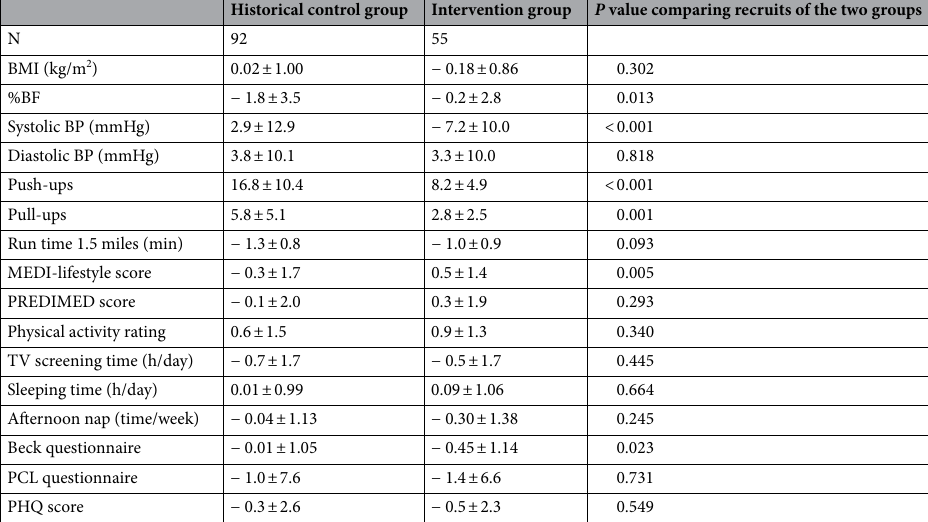
Table 2. Changes in recruits’ selected body composition and physical fitness measurements from baseline to graduation of the two groups. Mean ± SD. BMI, %BF, blood pressures, push-ups, pull-ups, run time, and MEDI-lifestyle score are only available for one academy of the intervention group (n = 37). BMI body mass index, %BF percent body fat, BP blood pressure, Beck Beck depression inventory for primary care, PCL post- traumatic stress disorder (PTSD) questionnaire, PHQ patient health